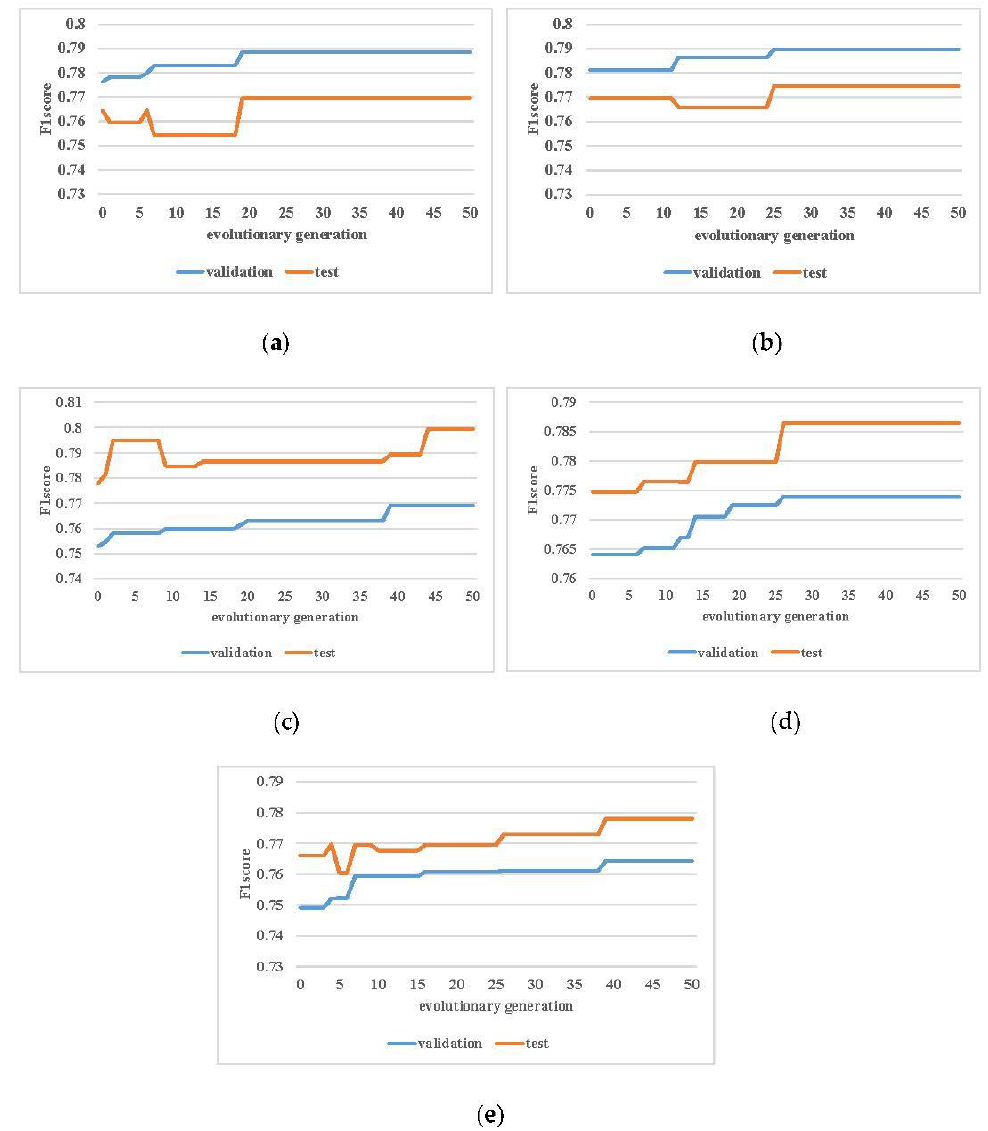
Figure 5. The evolution curve of each fold data in five-fold cross-validation. The blue curve represents the results of the validation dataset, and the orange curve represents the test dataset. The abscissa represents the current evolutionary generation, and the ordinate represents the F1-score of the current optimal individual. Among them, ( a – e ) are the evolution curves of each fold data in a five-fold cross-validation experiment.